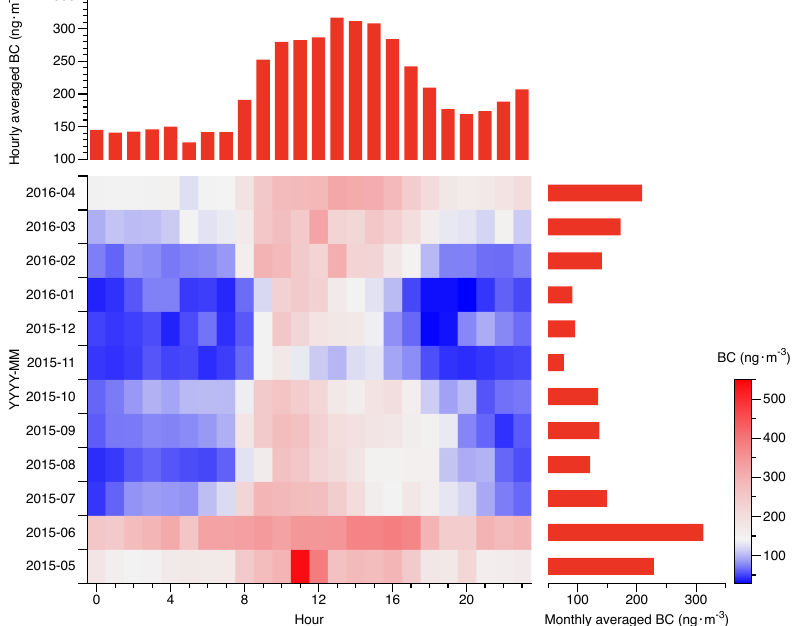
Figure 3. The temporal variation of BC on daily basis vertically, and hourly basis horizontally, including hourly and monthly averaged BC on the top and right panes, respectively, during May 2015 to April